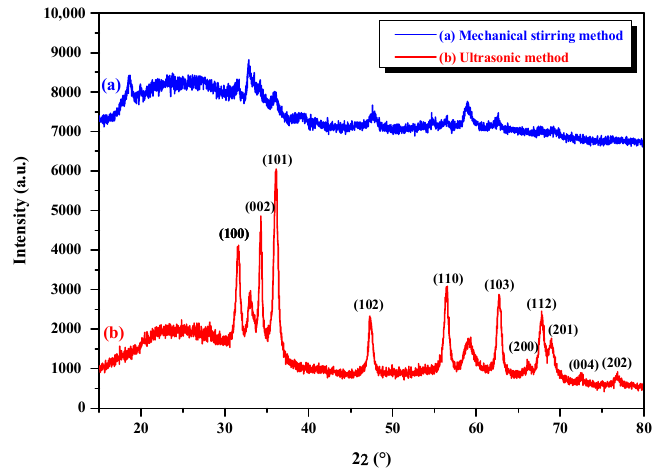
Figure 3. XRD patterns of nano-ZnO synthesized by mechanical stirring and ultrasonic methods.